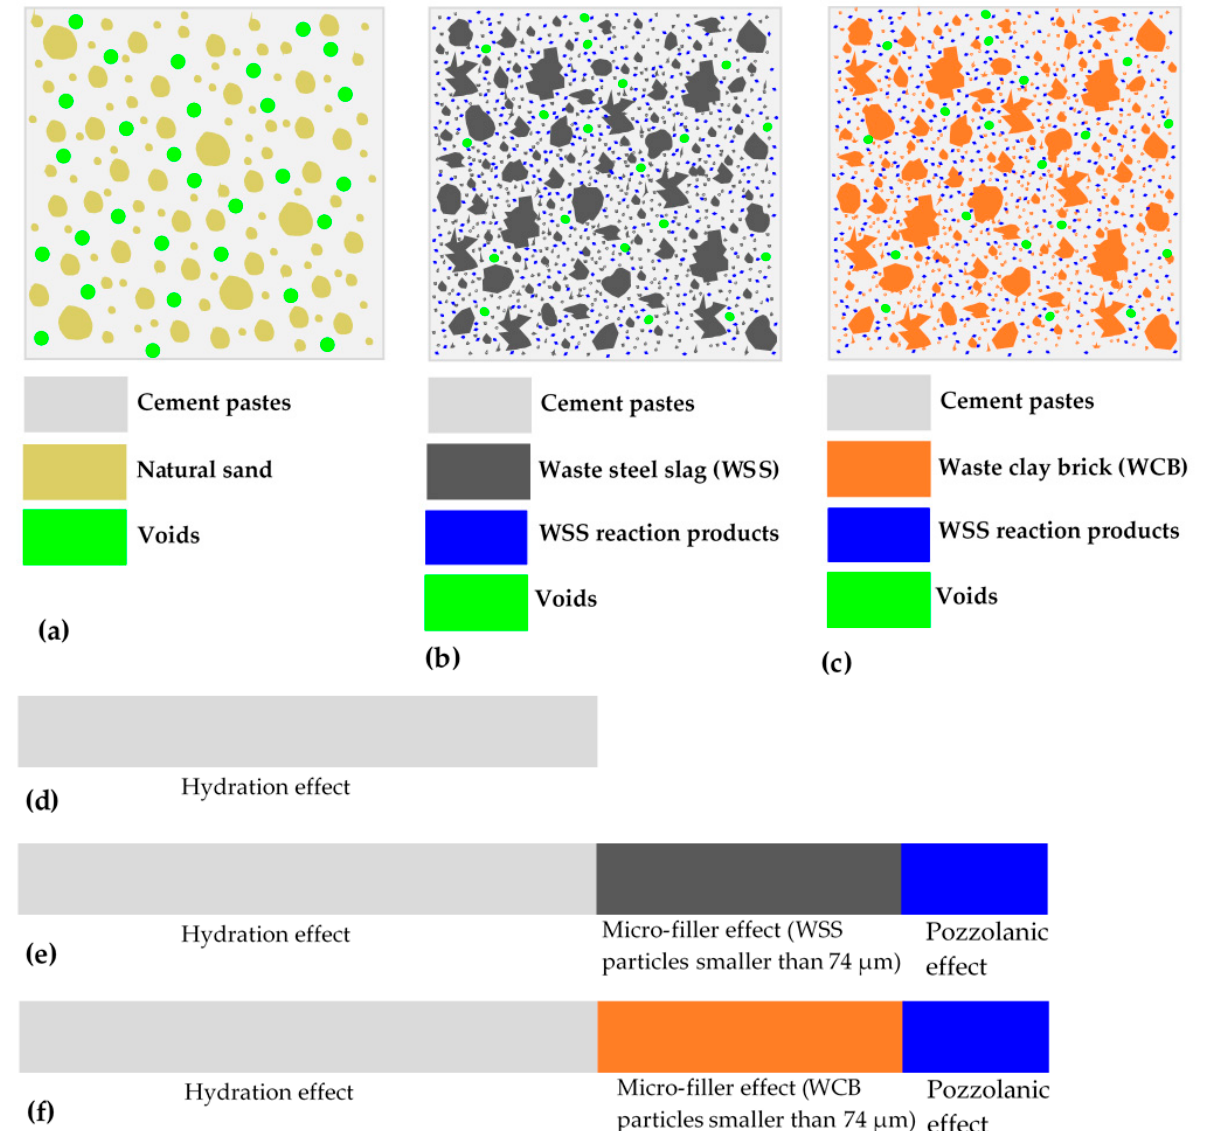
Figure 6. Conceptual diagram of the cross-section of the mortar made with 100% NS ( a ), 100% WSS ( b ) and 50% WCB ( c ) and the effect of cement hydration, micro-filler and pozzolanic action for 100% NS ( d ), 100% WSS ( e ) and 50% WCB ( f ) on the development of strength of mortar, respectively (dimensions of the objects in the figures are not actual).